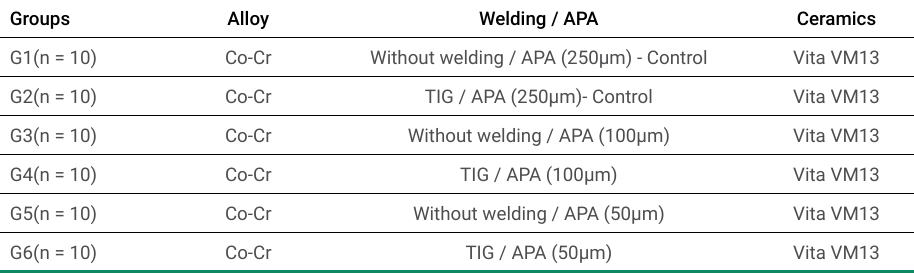
Table 2. Description of Groups. Groups